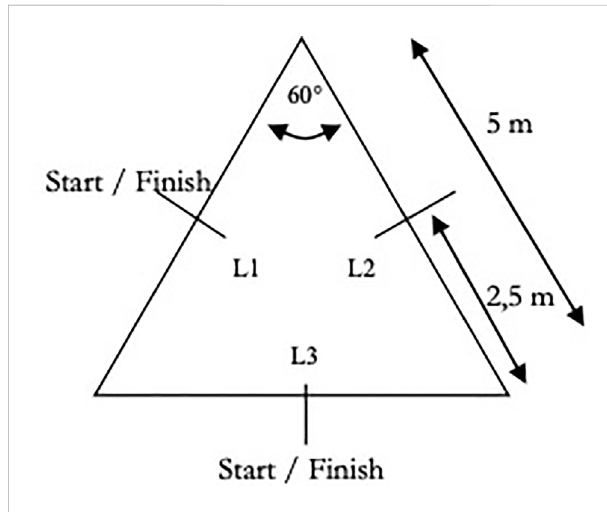
FIGURE 1 Illustration of the test procedure for the triangle